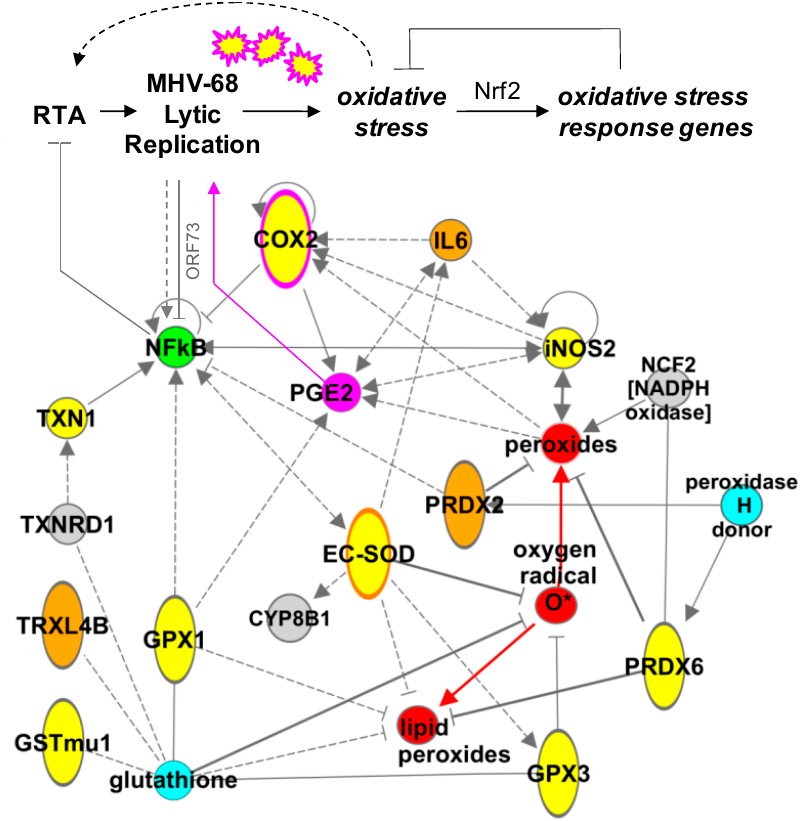
Figure 6. Oxidative stress network induced in mouse lungs by MHV-68. A sub-network of antioxidant proteins was extracted by IPA and manually curated. MHV-68 lytic infection induces reactive oxygen species (ROS) small molecules (red) that in turn induce oxidative stress response genes. Network model includes proteins induced in infected lungs by MHV-68 (yellow) or by IL6 in the context of MHV-68 infection (orange and orange-border) , proteins directly upregulated by MHV-68 lytic infection ( pink and pink-border , [52]), and NF-kB, which has a complex interaction with MHV-68 lytic replication ( green , [75]). Antioxidant co-factors (aqua) , other redox proteins (gray) , activating interactions (arrows) , indirect regulation (dashed arrows and bars) , and inhibitory interactions (blocking bars) indicate the potential complexity of even a small-scale redox network in vivo.